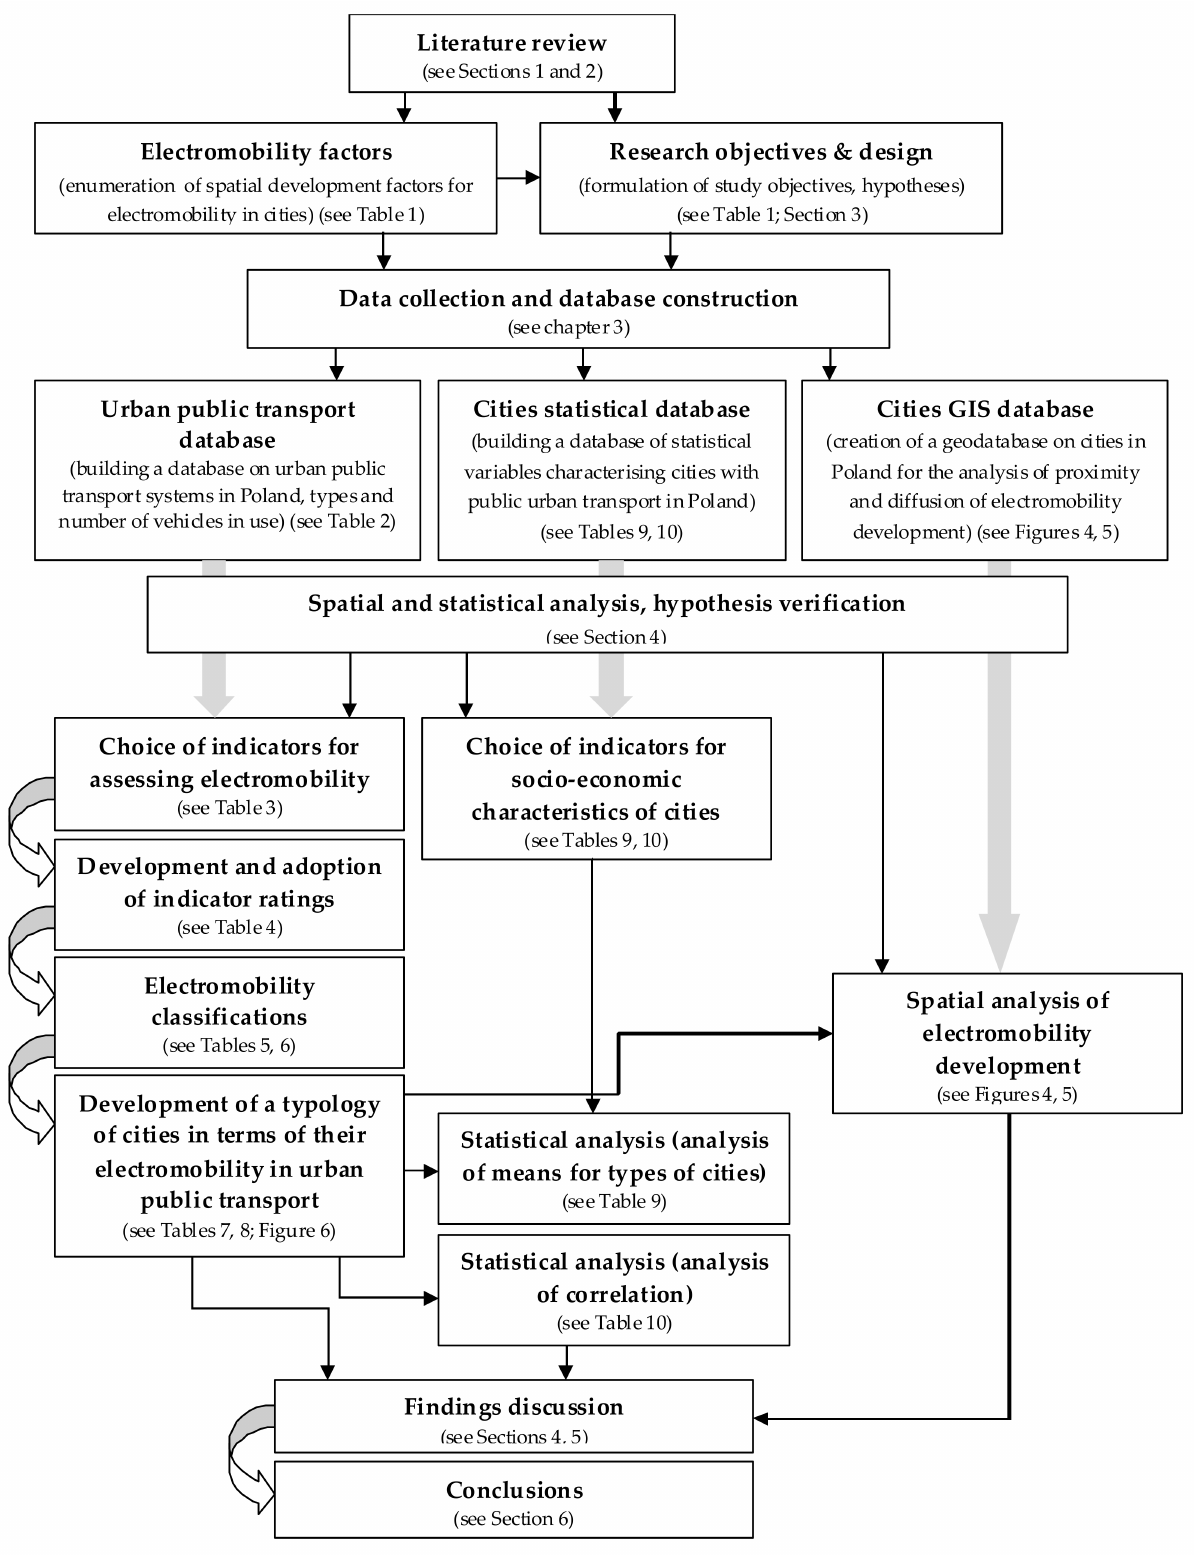
Figure 3. The research procedure